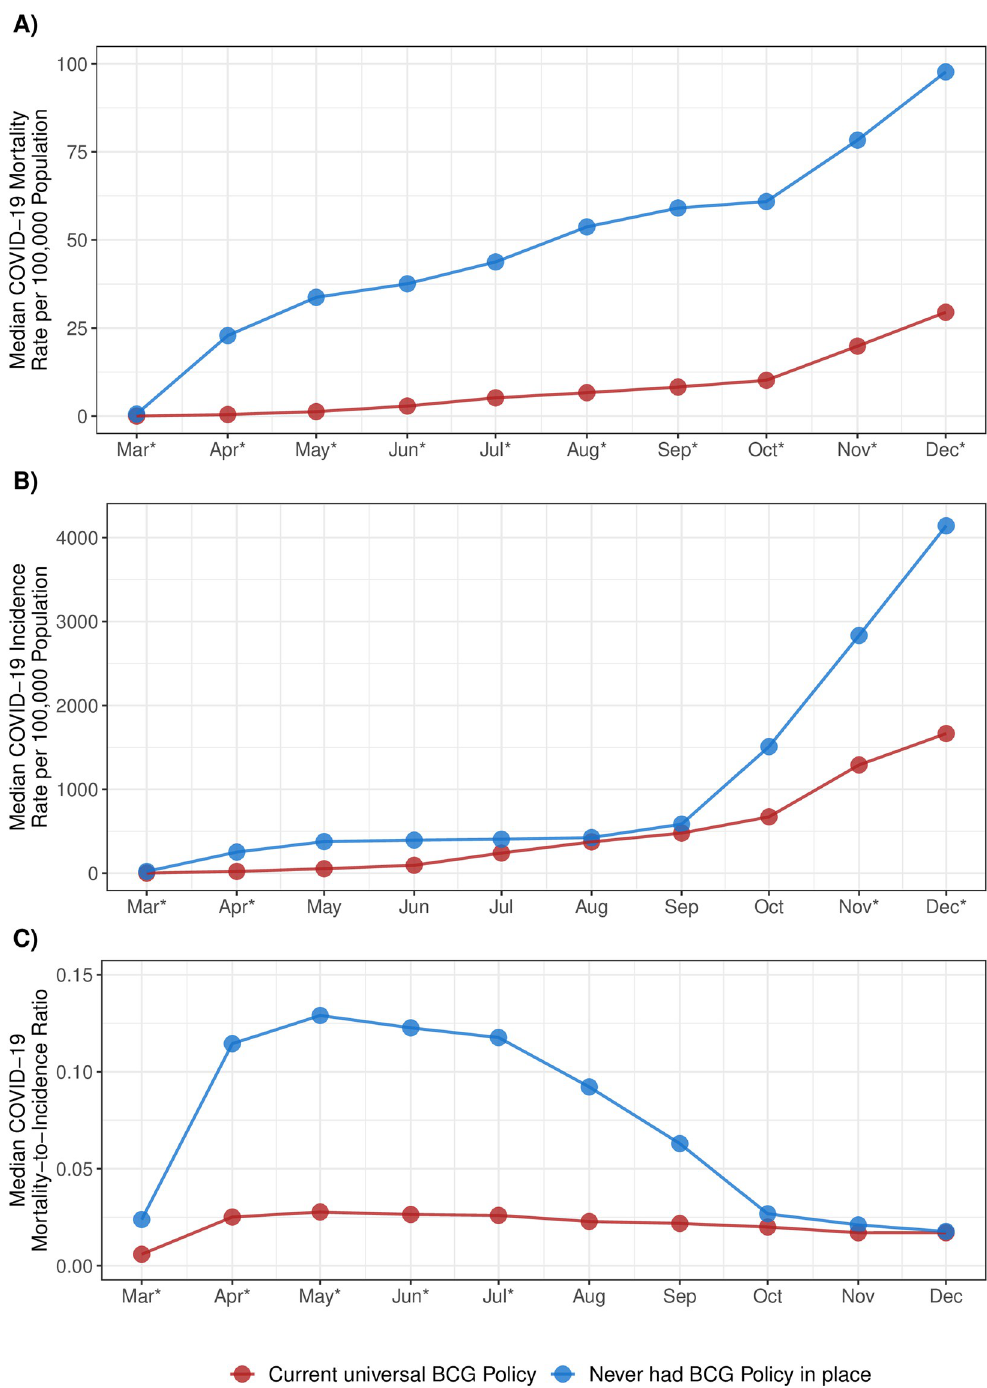
Fig 1. Median COVID-19 mortality rate per 100,000 population (A), incidence rate per 100,000 population (B), and mortality-to-incidence ratio (C) by BCG policy status, March-December, 2020. � Statistically significant at p < 0.05 using Wilcoxon Rank Sum